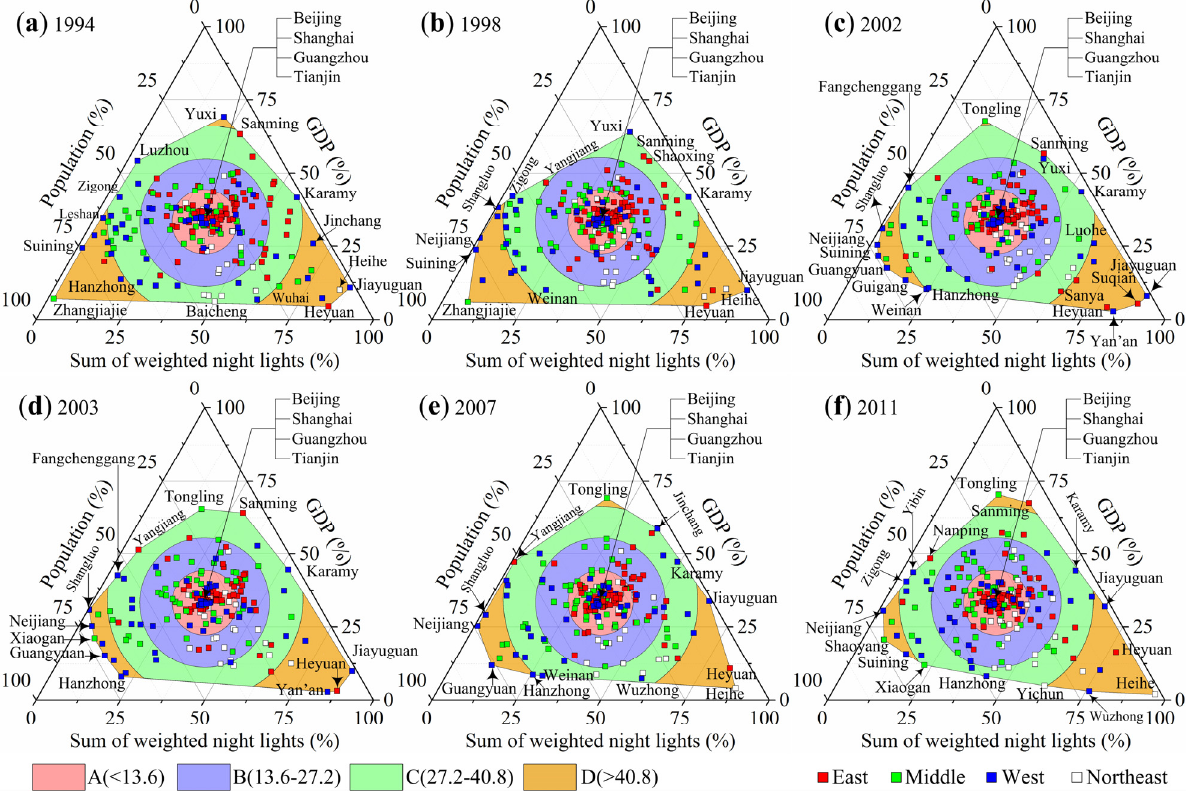
Figure 5. Ternary plots and classification statuses of 226 China’s cities in 1994 ( a ), 1998 ( b